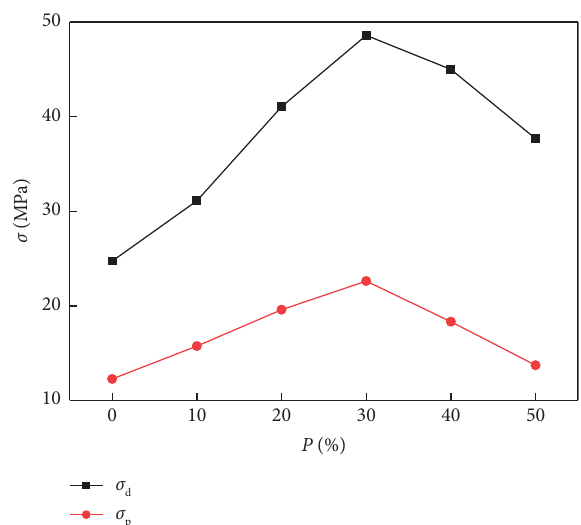
Figure 8: Dynamic stress variation of concrete with the change of fy ash contents.